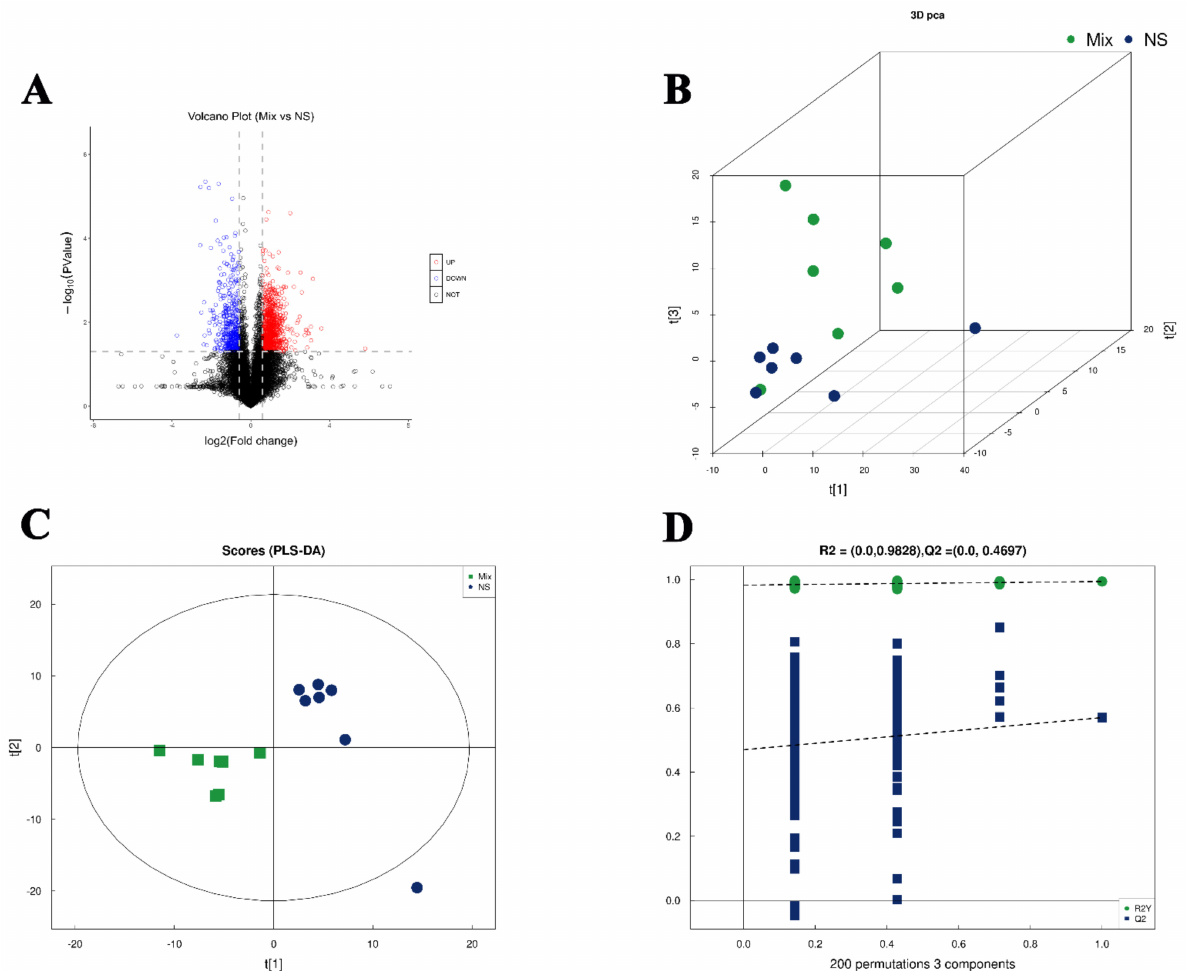
Figure 8. ( A ) Volcanograms showing up- and downregulated metabolites between NS and Mix group. Blue color indicates downregulated metabolites, while red color represents upregulated metabolites. ( B ) Score plot of 3D principal component analysis between NS and Mix group. ( C ) Score plot of partial least-squares discriminant analysis between NS and Mix group. ( D ) Corresponding validation plot from NS and Mix